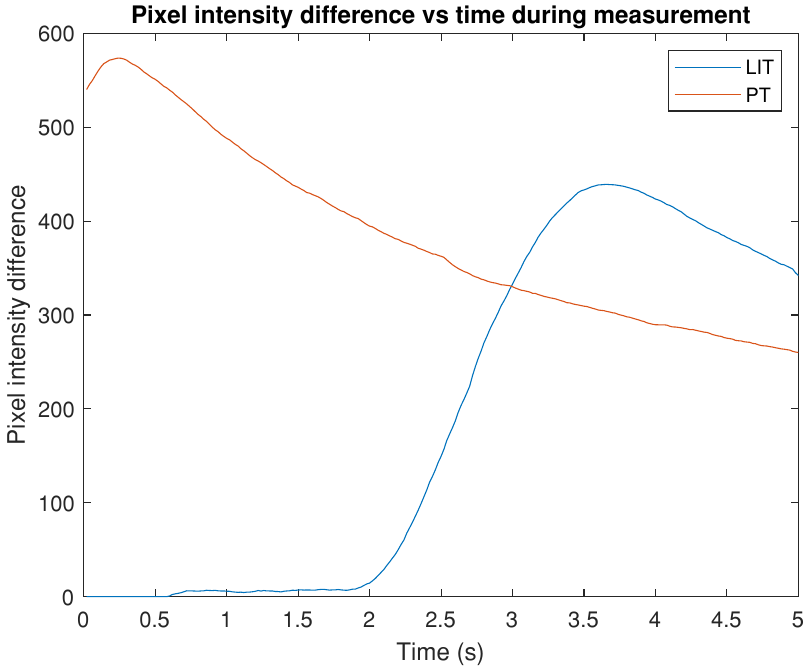
Figure 3. Pixel intensity evolution during a measurement. For the LIT measurement, the entire measurement cycle is shown. For the PT measurement, the cool-down process is